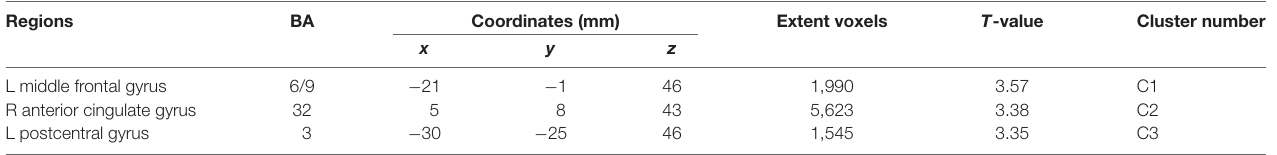
TABLE 2 | Positive correlations between regional cerebral glucose metabolism and The Korean Adult Reading Test (KART)-estimated full-scale IQ (FSIQ) score after adjusting for age and gender in all cognitively normal (CN) subjects. Regions BA